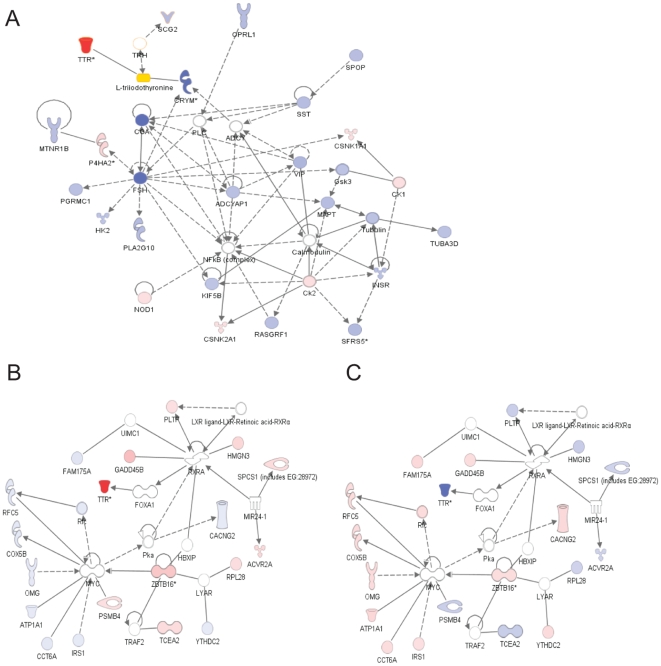
Representative gene network discovered by Ingenuity Pathway Analysis.A) A network affected in AC vs. SC comparison. Red represents up-regulation of the gene in autumn control (AC) vs. spring control (SC), whereas blue represents down-regulation. Color intensity correlates with a degree of fold change. Thyroid hormone (L-triiodothyronine, T3) is highlighted by yellow. White represents genes that were either not differentially expressed, not been annotated, or not in the custom-made array. B&C) A network affected by interaction (season×STI). The same network shown with expression fold-changes for SE vs. SC (B) or AE vs. AC (C). Red represents up-regulation of the gene in STIs (SE in B, AE in C) when compared with controls (SC in B, AC in C), whereas blue represents down-regulation. Same as (A) for the white. When there were multiple cDNA clone spots per gene, fold change values that were of most significance were selected.